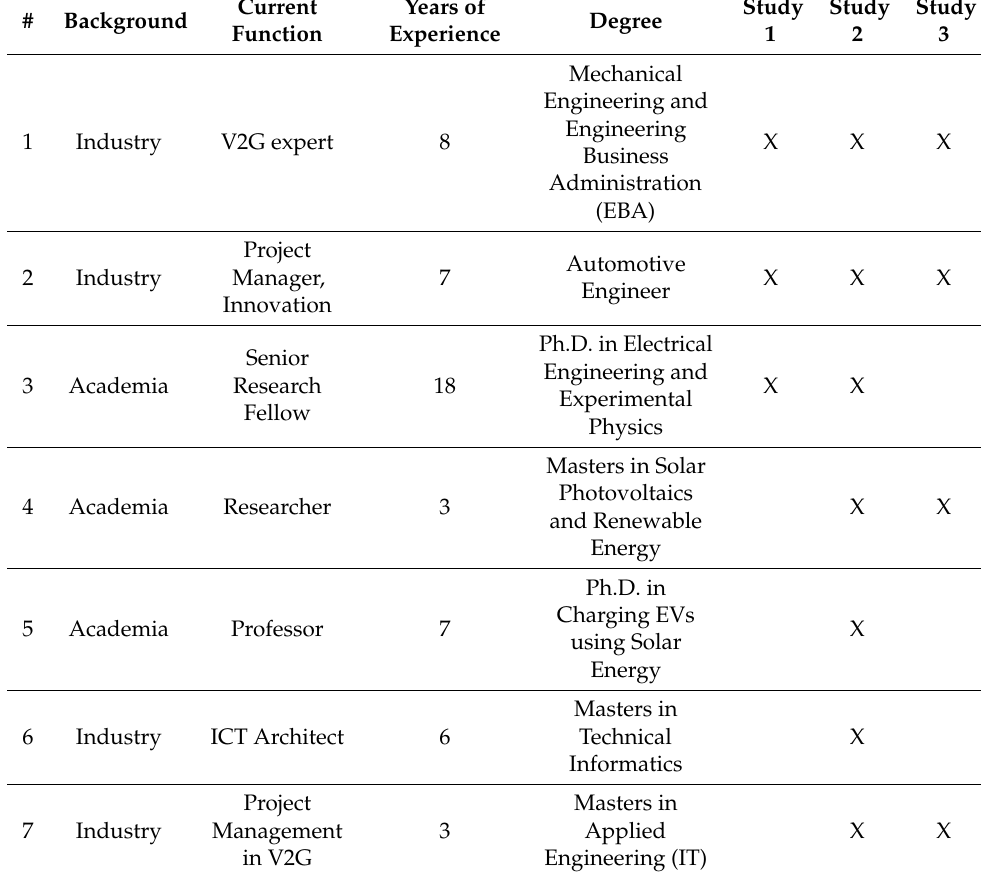
Table 1. The last three columns indicate which respondent participated in which study. Table 1.